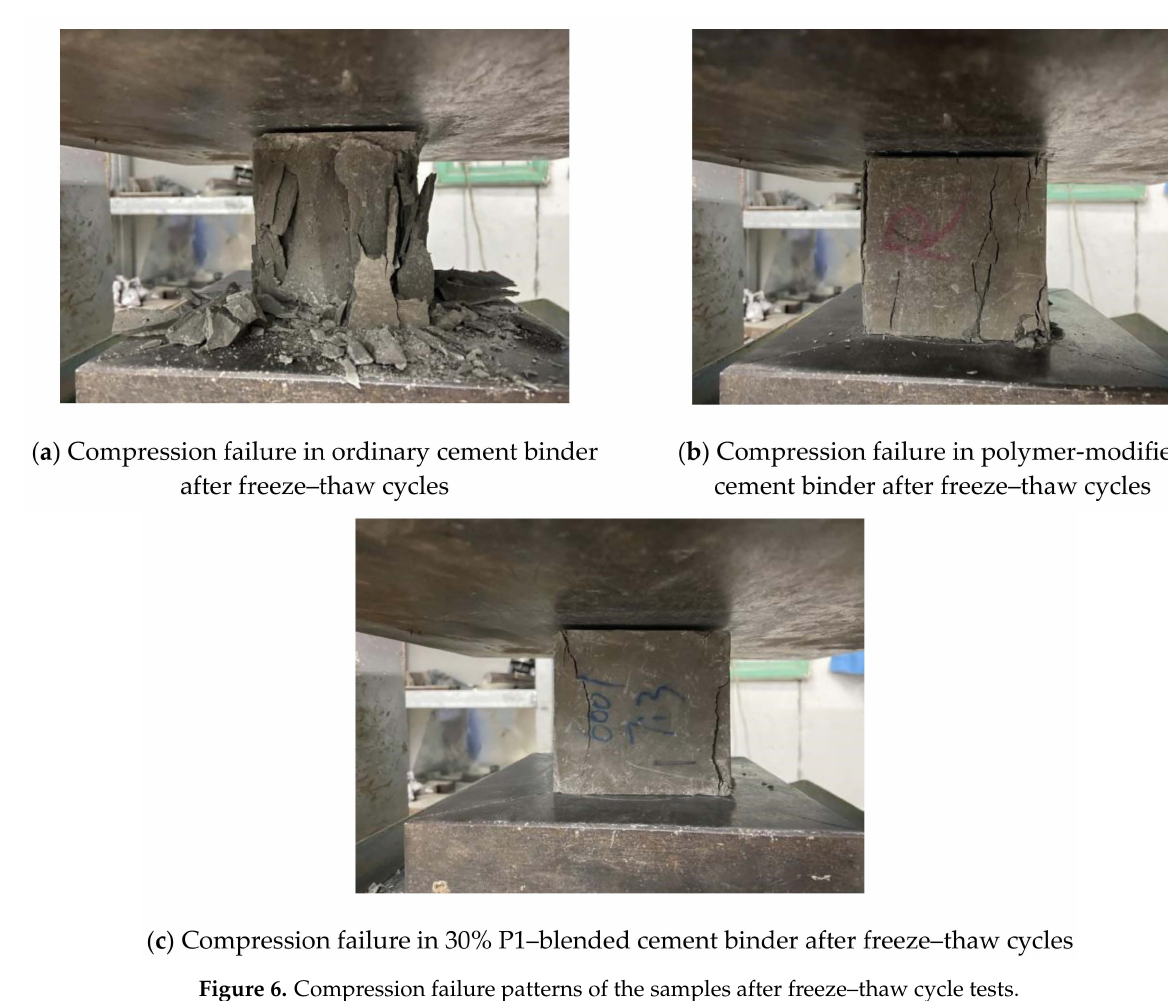
Figure 6. Compression failure patterns of the samples after freeze–thaw cycle